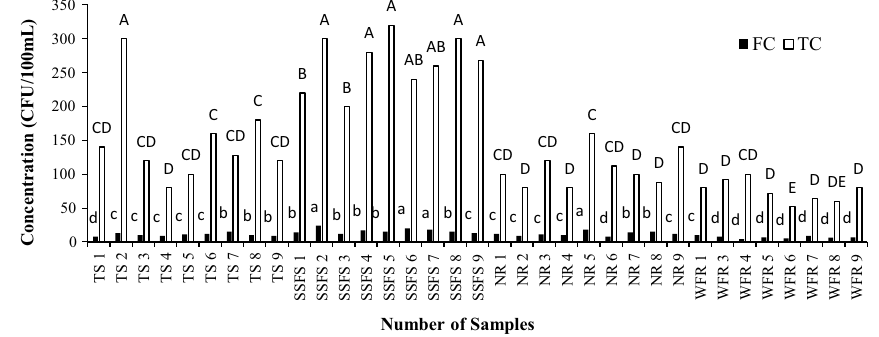
Fig. 3 Concentration of Fecal Coliform (FC) and Total Coli- form (TC) in different sources of food stalls. NR = Normal Restaurants, TS = Tea Stalls, SSFS = Street Side Fast Food Stalls and WFR = Well-fur- nished Restaurants. Bars with different letters are significantly different ( p < 0.05) according